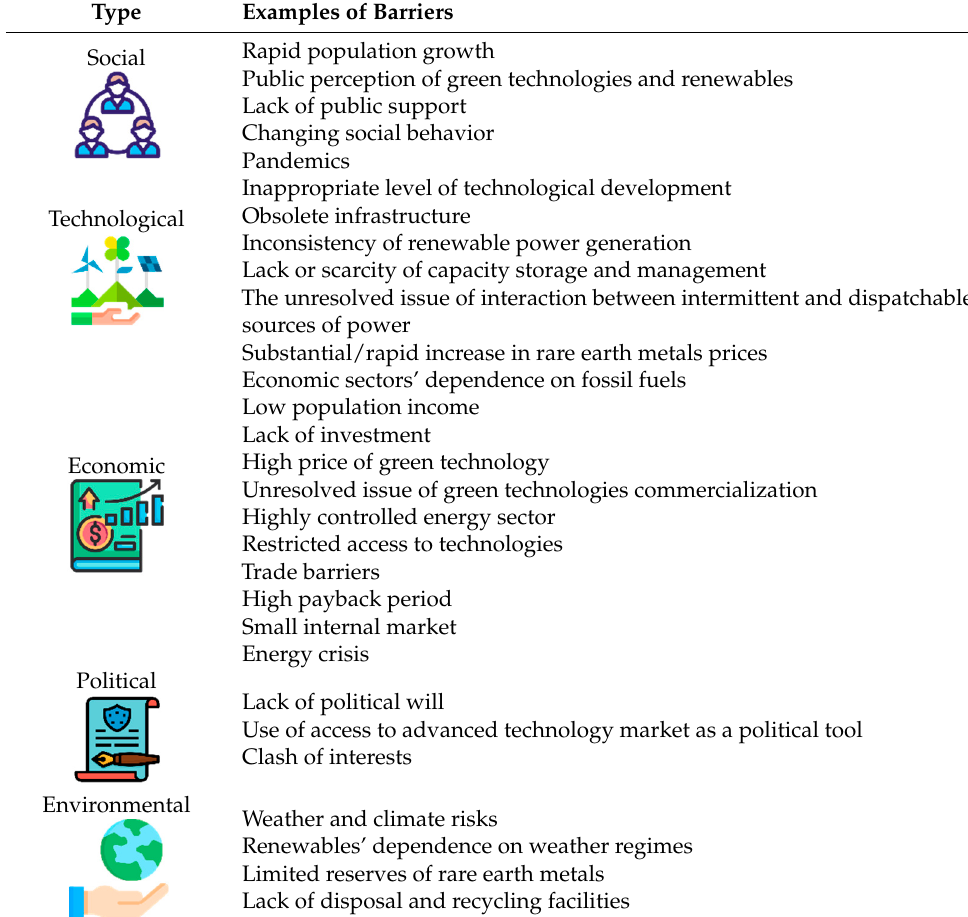
Table 5. Existing and potential barriers of energy transition.